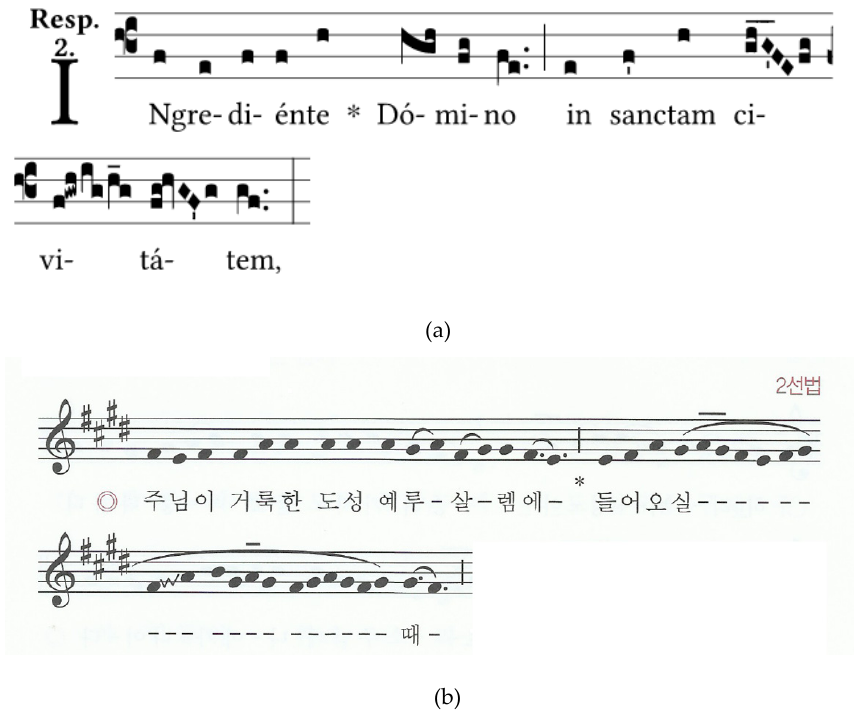
Figure 4. Comparison between the original Latin ( a ) and Korean ( b ) scores of “Ingrediente Domino” (A Database of Gregorian Scores 2021; Catholic Conference of Korea 2021).